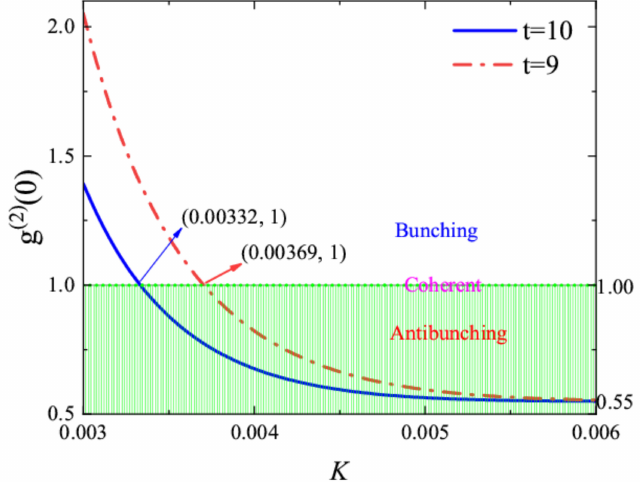
Figure 4. The second-order correlation function as a function of K , where K is dimensionless in units of ω , α a = 10, g = 10 K and α m =